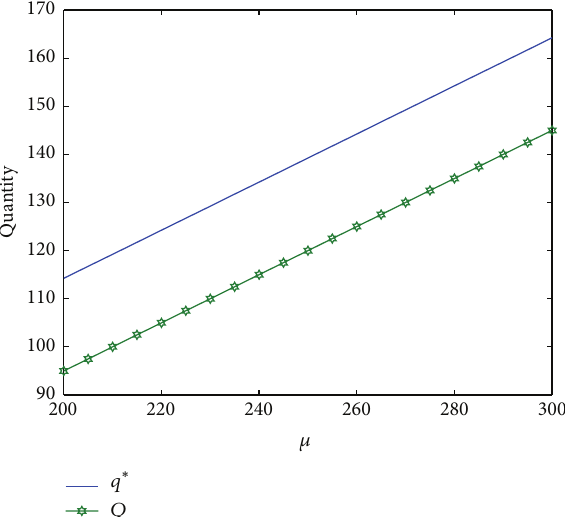
Figure 6: Impact of 𝛼 2 on pricings under demand certainty and uncertainty.